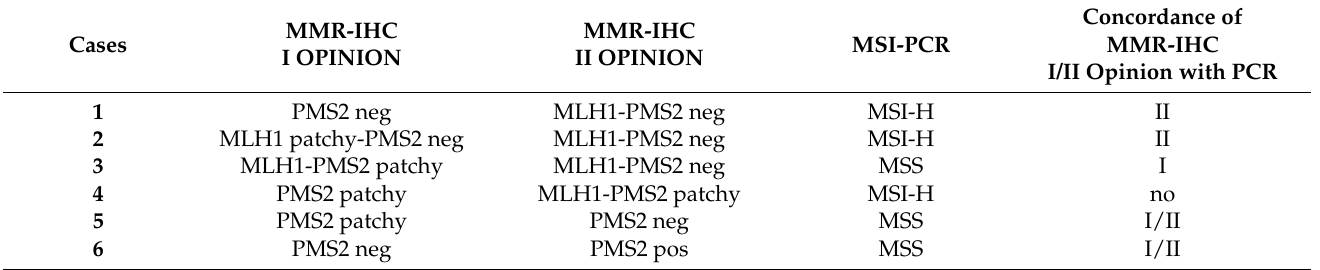
Table 3. Second diagnostic opinion of MMR-IHC analysis and comparison with MSI-PCR results in CRC